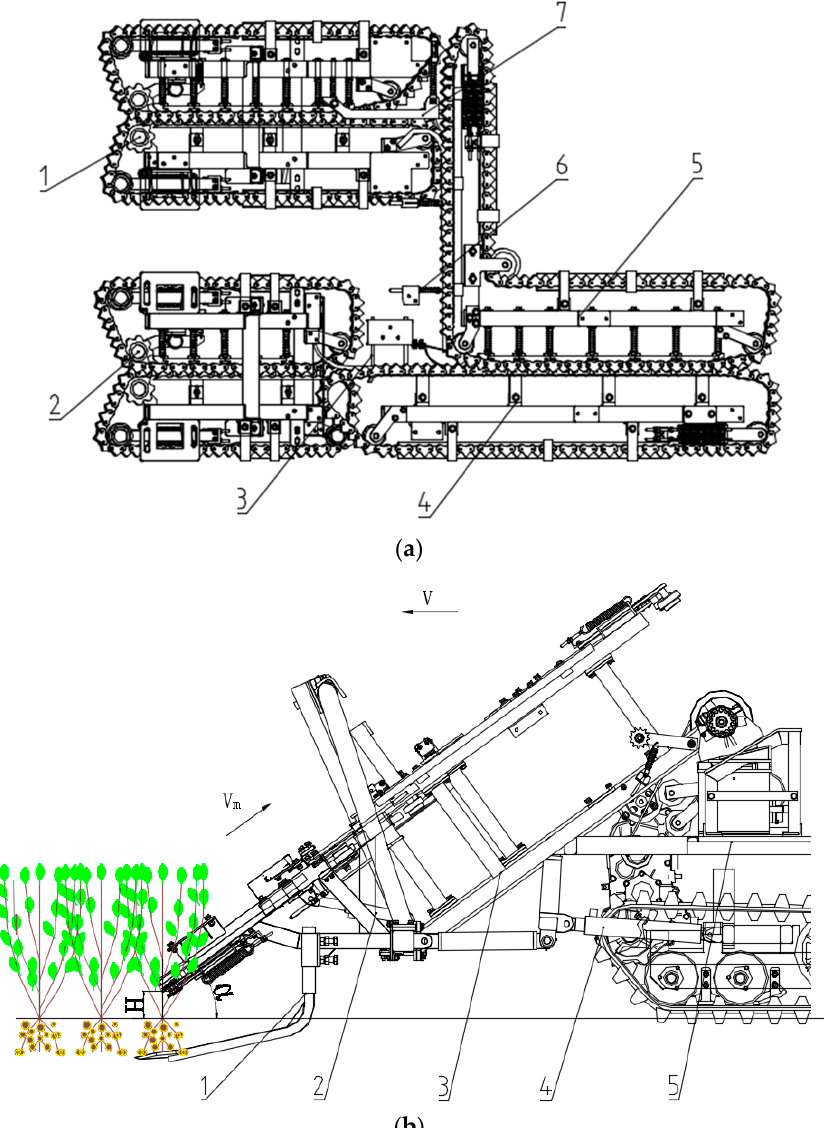
Figure 4. The clamping and pulling conveying device. ( a ) Sketch of the structure of the clamping and pulling conveying device: 1. right clamping conveyor; 2. left clamping conveyor; 3. left com- pression bar; 4. left merging conveyor; 5. right merging conveyor; 6. adjustable flexible lever; 7. right compression bar. ( b ) Side view of the structure of the clamping and pulling conveying device: 1. excavation shovel; 2. left and right clamping and drawing devices; 3. harvesting unit stand; 4. har- vesting unit total adjusting cylinder; 5. Chassis.